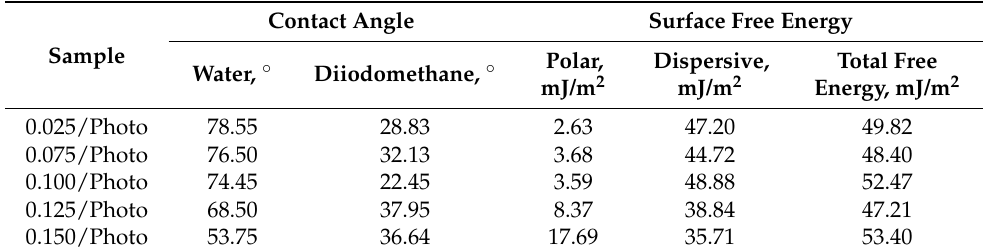
Table 2. Parameters determined during the wettability